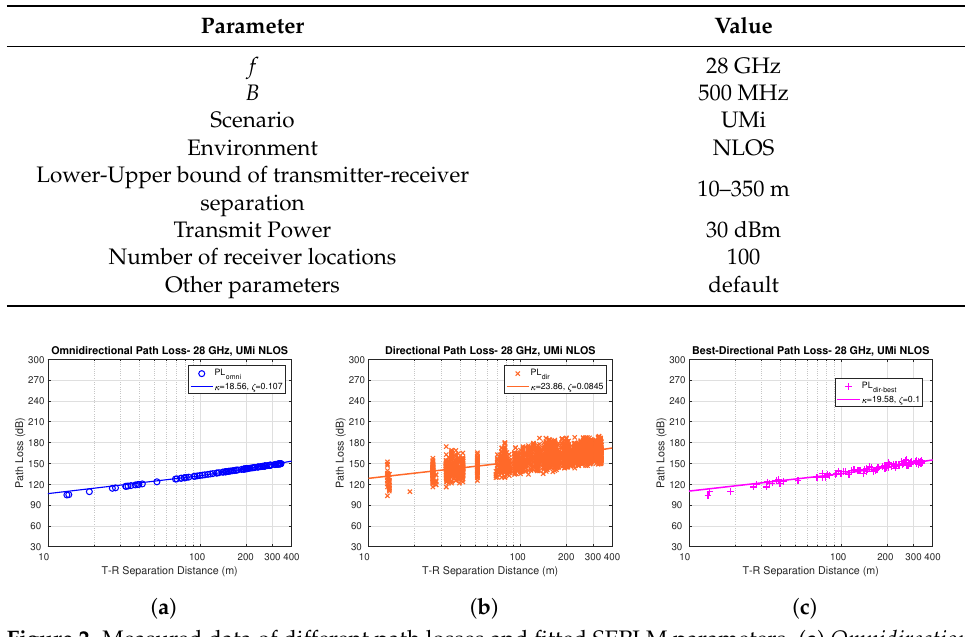
Table 2. Input parameters to NYUSIM.